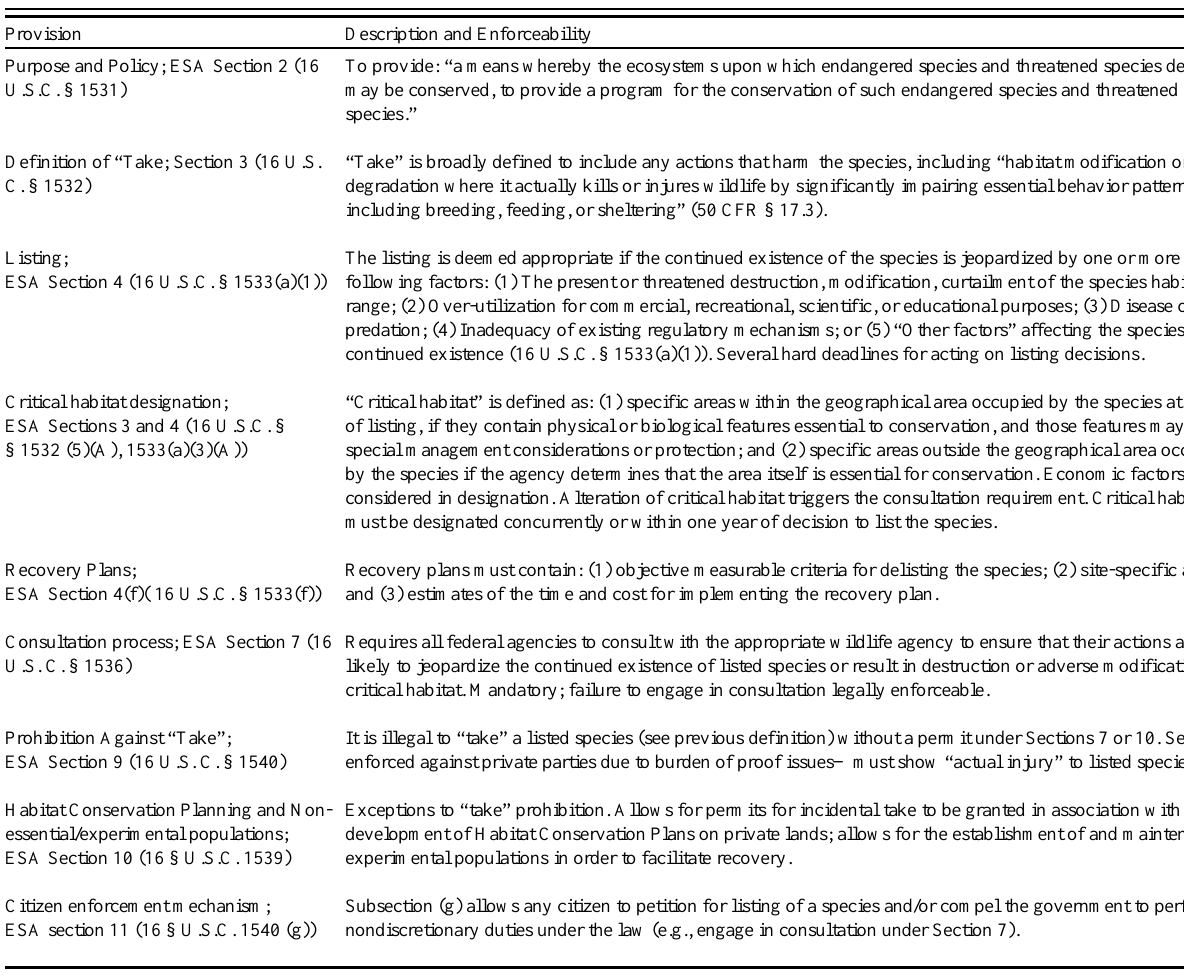
Table 1 . Key Provisions of the Endangered Species